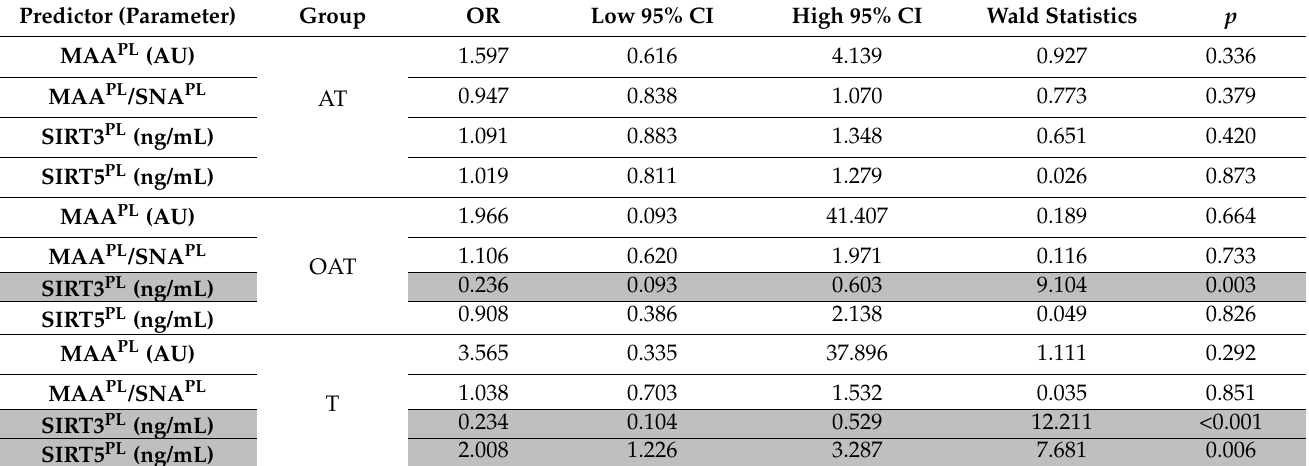
Table 4. The results of multinomial logistic regression analysis of selected seminal plasma